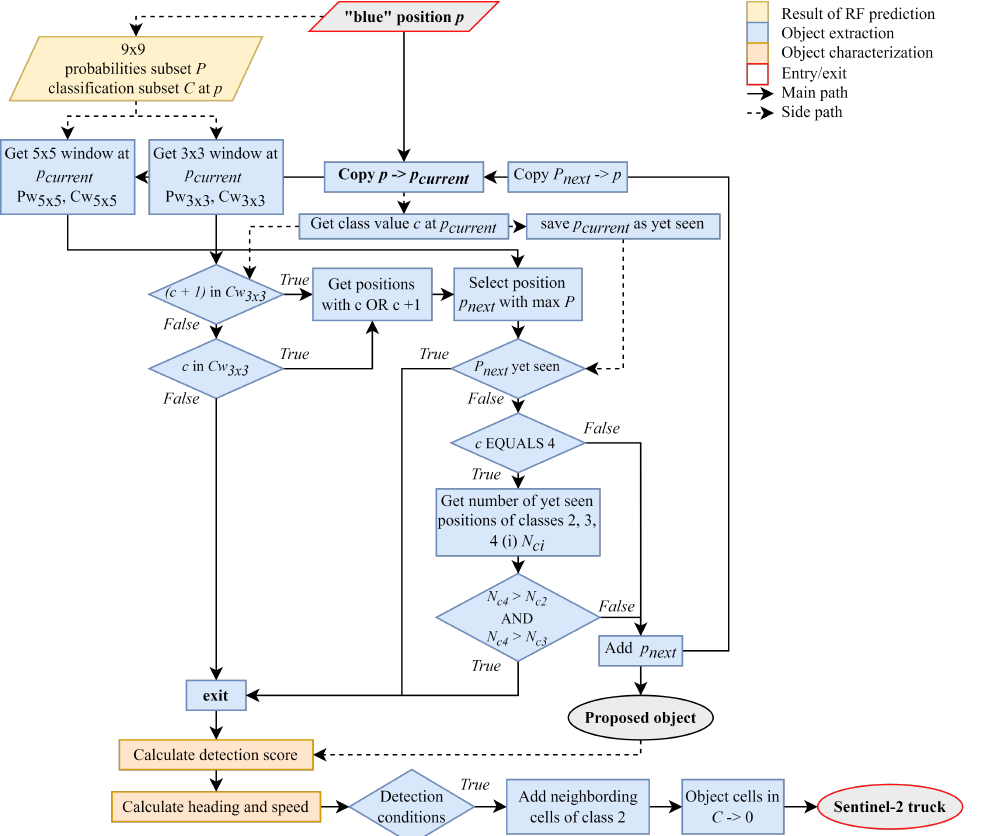
Figure 7. Object extraction procedure. Input is a two-dimensional array coordinate of a pixel classified as